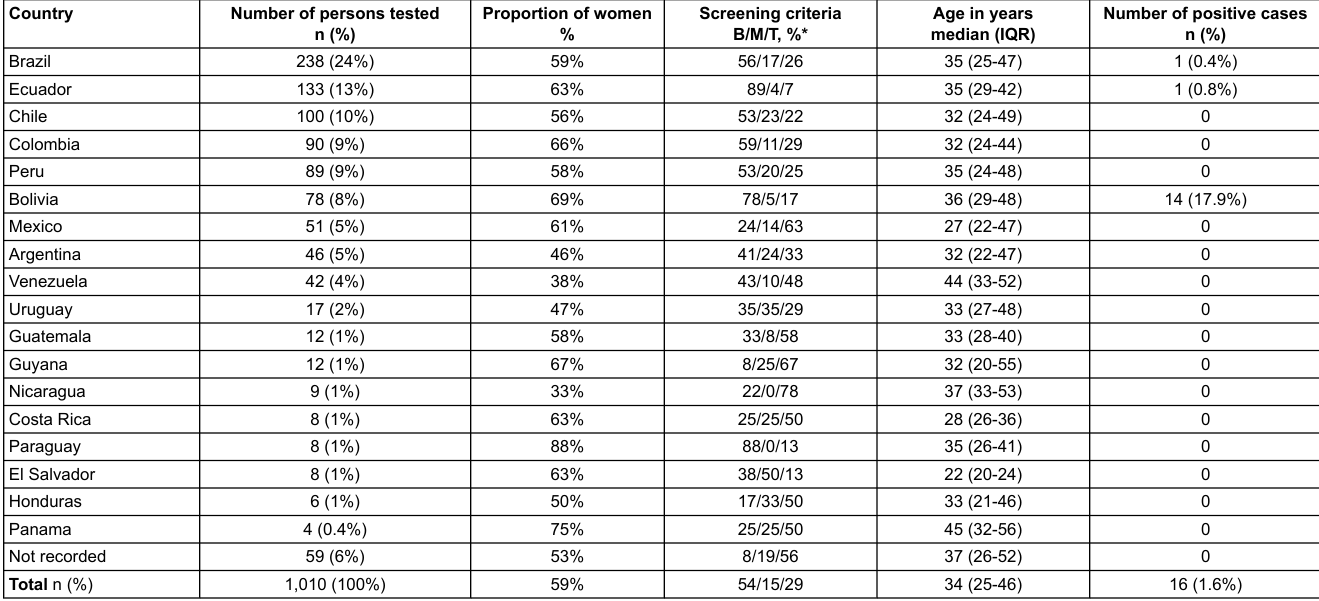
Table 2: Number of persons tested, proportion of women, distribution of screening criteria, median age and number of positive cases, by country. Country Number of persons tested n